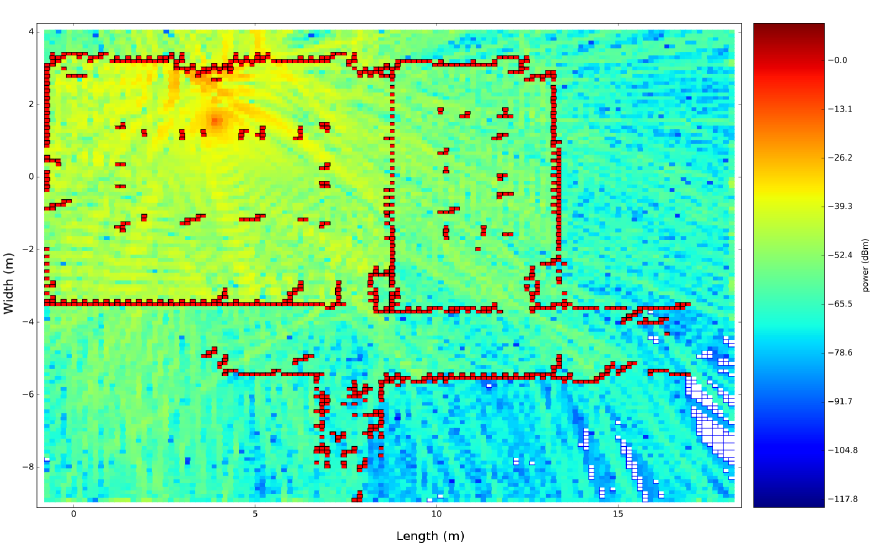
Figure 29. Heatmap of transmitter number